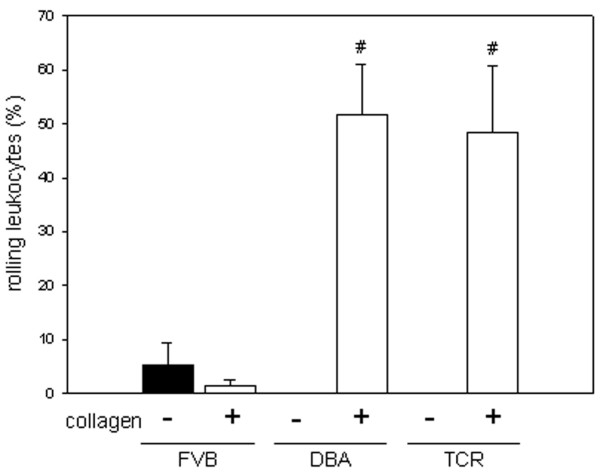
Leucocytes rolling along the endothelium of postcapillary synovial venules. Shown are the proportions of leucocytes rolling along the endothelium of postcapillary synovial venules (as % of all passing leucocytes) in complete Freund's adjuvant (CFA)/collagen II exposed FVB/NJ, DBA1/J and T-cell receptor (TCR) transgenic mice (collagen +) in comparison with CFA treated controls (collagen -). Intravital fluorescence microscopy of the knee joints was performed at 6 weeks after collagen exposure for induction of arthritis. Values are expressed as means ± standard error (n = 5–10 animals/group); analysis of variance, unpaired post hoc comparison test: #P < 0.05 versus corresponding CFA-treated control animals (collagen -).